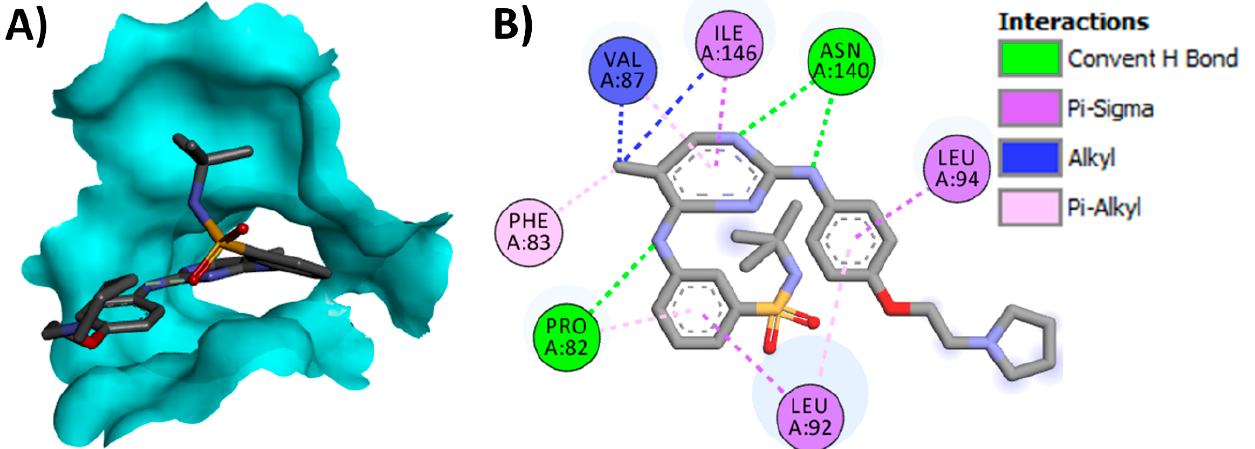
Figure 29. Binding modes of fedratinib (shown as sticks) into human bromodomain BRD4 (pdb: 4PS5): ( A ) 3D binding mode, receptor shown as a hydrogen bond surface; ( B ) 2D binding mode showing different types of interactions with BRD4; the figure was generated using Discovery Studio Visualizer (V16.1.0.15350).